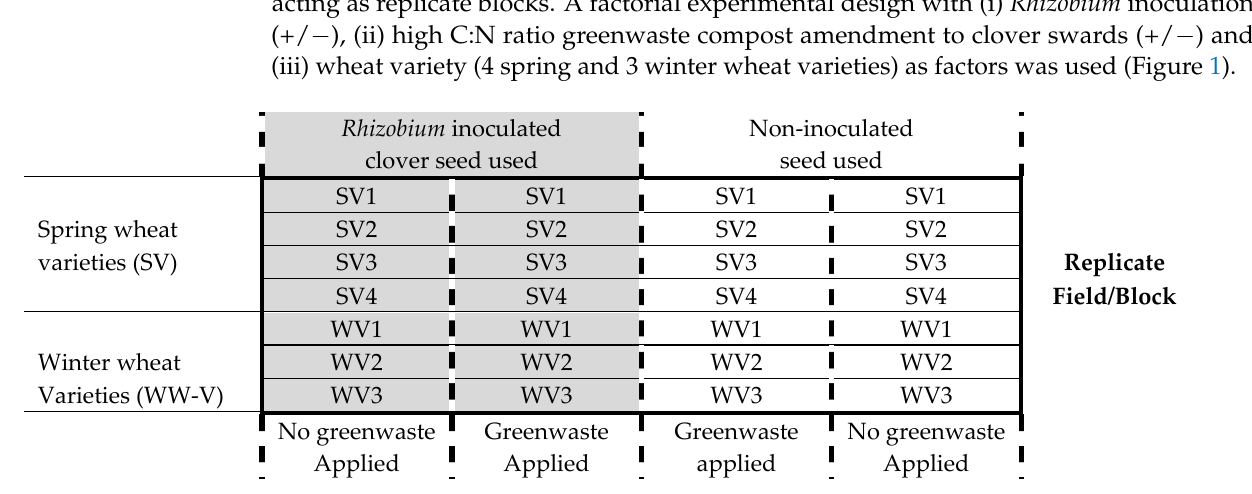
Figure 1. Field trial design Rhizobium inoculation main plots, greenwaste amendment subplots and variety sub-subplots in each replicate field/block.